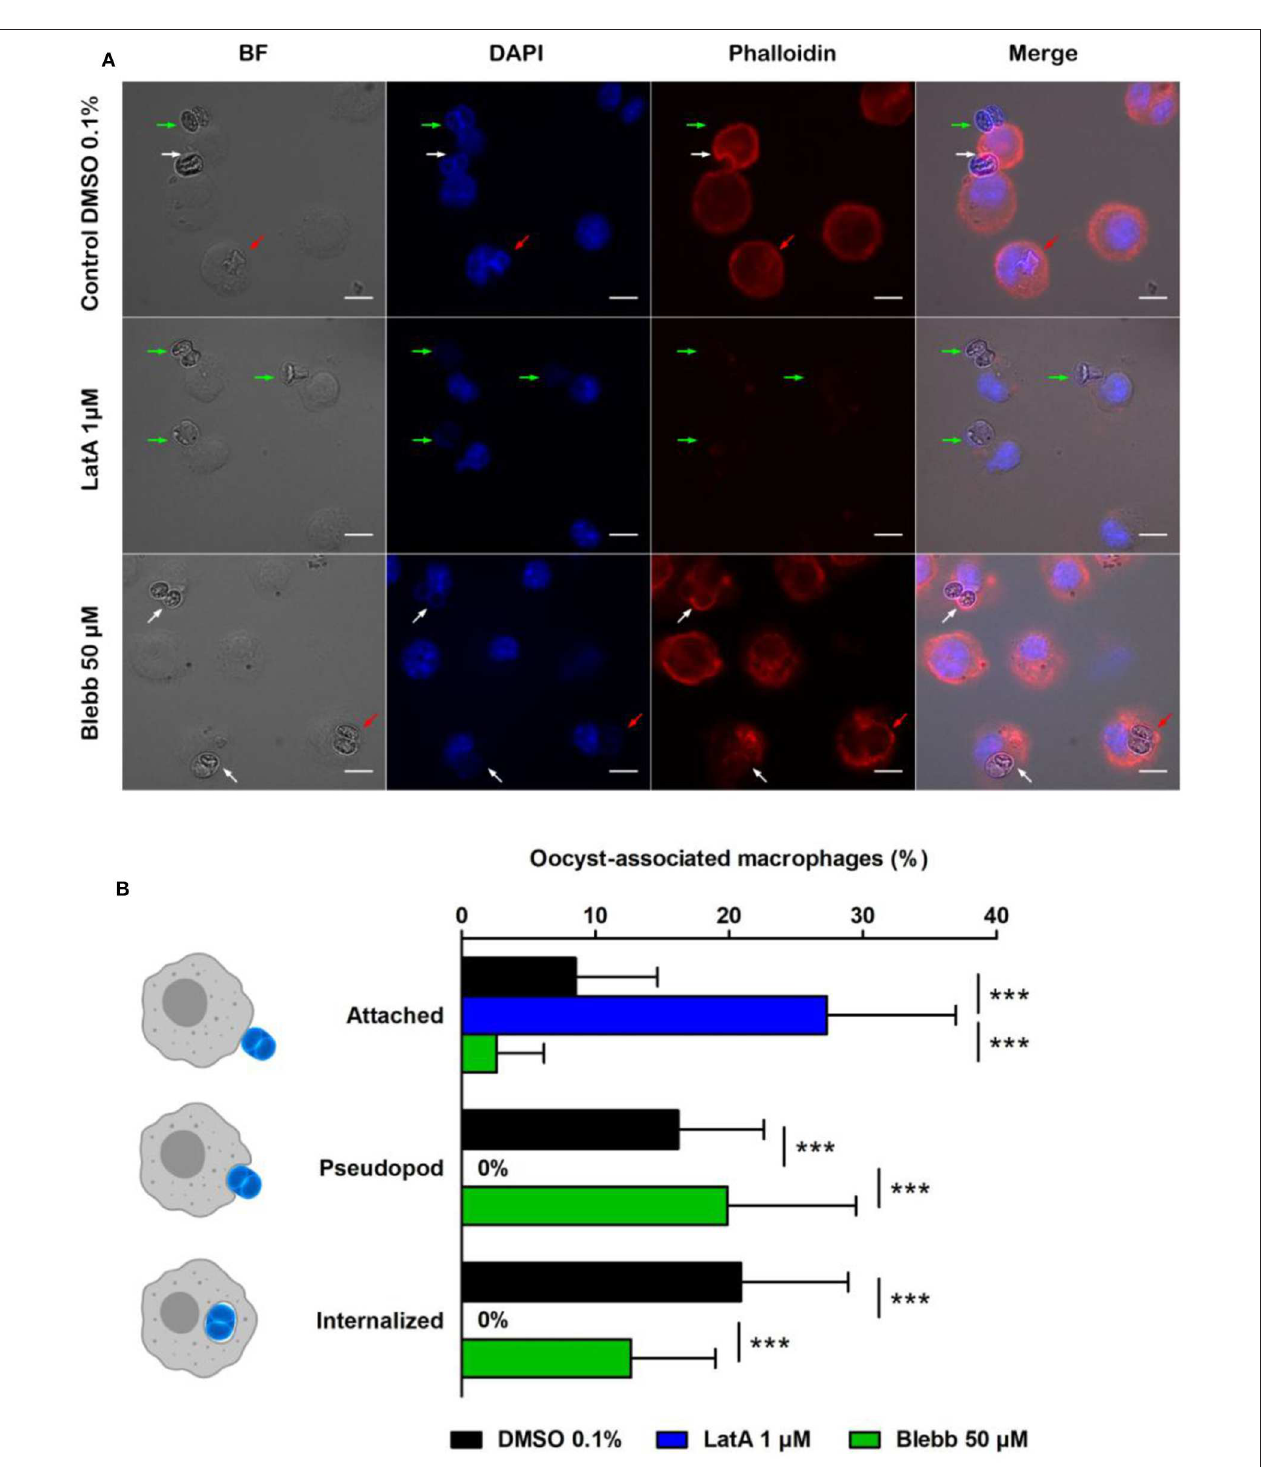
FIGURE 2 | Interactions of Toxoplasma gondii oocysts with RAW macrophages in the presence of inhibitors of actin polymerization (latrunculin A, LatA) or myosin II (blebbistatin, Blebb). (A) Microscopic monitoring showing macrophages with oocysts attached to their membrane (green arrow), engulfing the parasite (white arrow) or having internalized it (red arrow). BF, bright field; DAPI channel, natural fluorescence of oocysts and macrophage nucleus; phalloidin, macrophage actin cytoskeleton. Scale = 10 µ m. (B) Percentage of macrophages with an oocyst attached to their membrane, engulfing the parasite (pseudopod stage), or having completely internalized it after 1h of treatment with 1 µ M LatA, 50 µ M Blebb, or 0.1% DMSO (control). The values correspond to the mean ± standard deviation of 4 independent experiments. One-way ANOVA and Tukey’s post-test, *** p < 0.001.